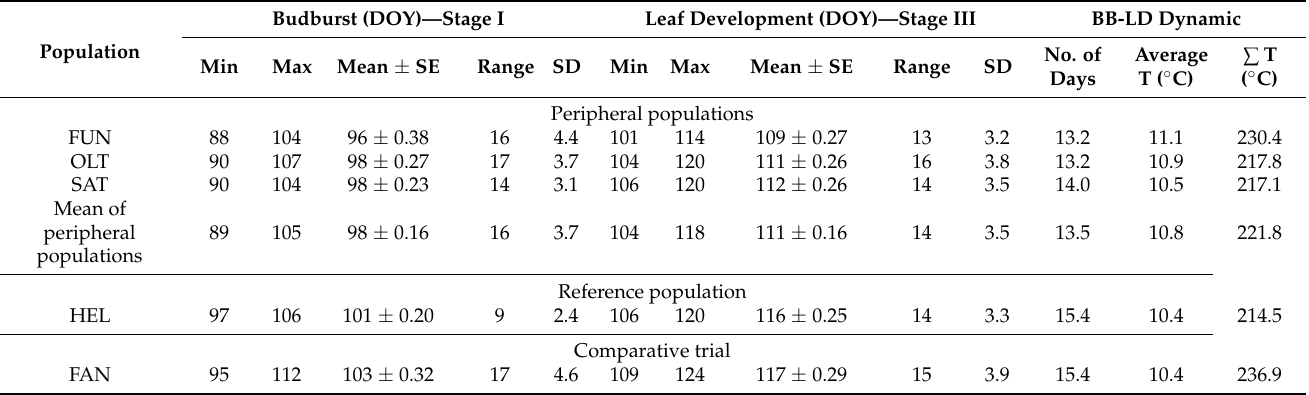
Table 3. Characteristic values of budburst and leaf development phenophases date observed for sessile oak in the analysed populations and FAN comparative trial for the period 2017–2020.